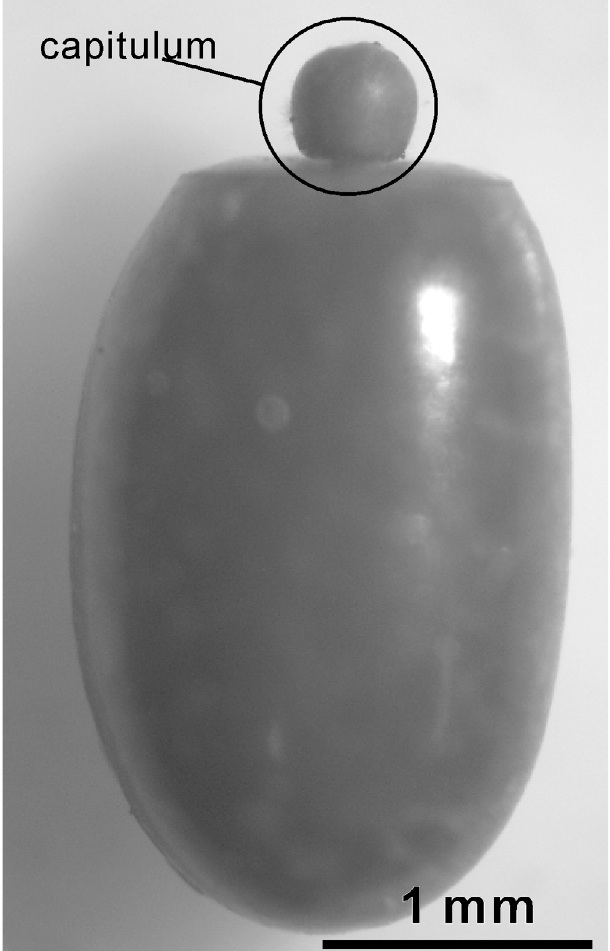
Fig 1 . Photograph of a Phraortes illepidus egg, which bears a